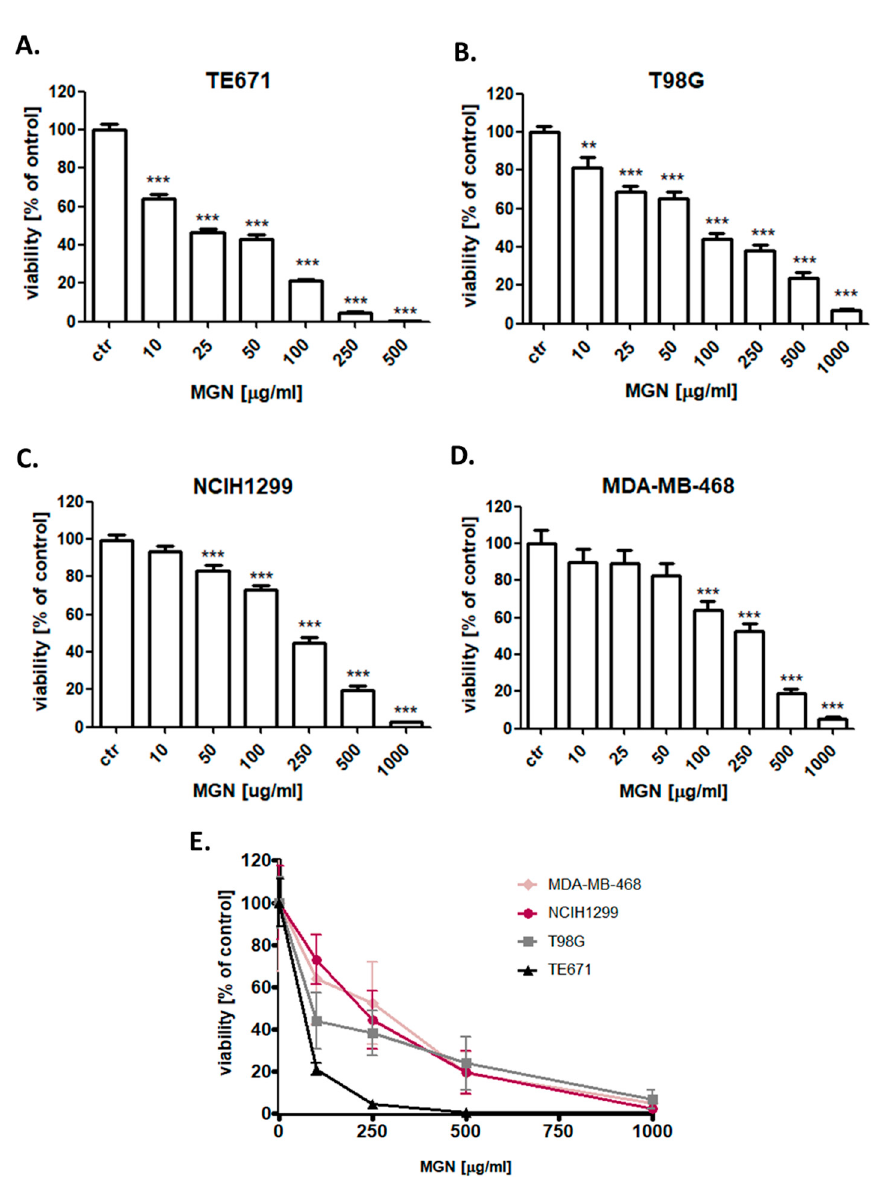
Figure 2. The anti-proliferative effects of magnoflorine (MGN) in ( A ) TE671 ( B ) T98G ( C ) NCIH1299 ( D ) MDA-MB-468 and ( E ) all analyzed cancer cell lines after 96 h treatment with various concentrations (10–1000 µg/ml) of an active agent. The cell viability was measured by the MTT assay. Results were analyzed using GraphPad Prism 5.0 software (one-way ANOVA; Tukey post-hoc testing). Statistical differences were considered relevant at p < 0.05 (** p < 0.01, *** p < 0.001). Data are expressed as mean ± standard deviation of the mean (± SD); n = 24 per concentration from three independent experiments.